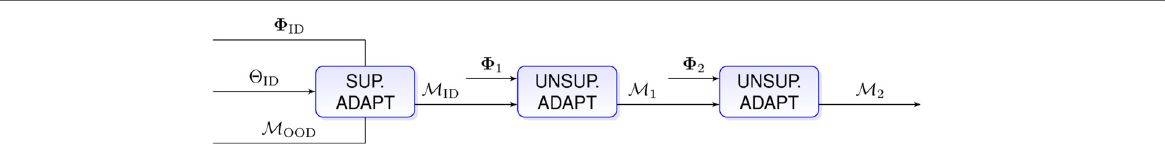
Fig. 11 Semi-supervised adaptation strategy based on the longitudinal unsupervised adaptation approach for the episodes 1 and 2. M OOD represents the out-of-domain model, M ID depicts the show in-domain model and M 1 and M 2 the adapted models for each episode. (cid:4) ID and (cid:6) ID symbolize the in-domain i-vectors and its speaker labels.